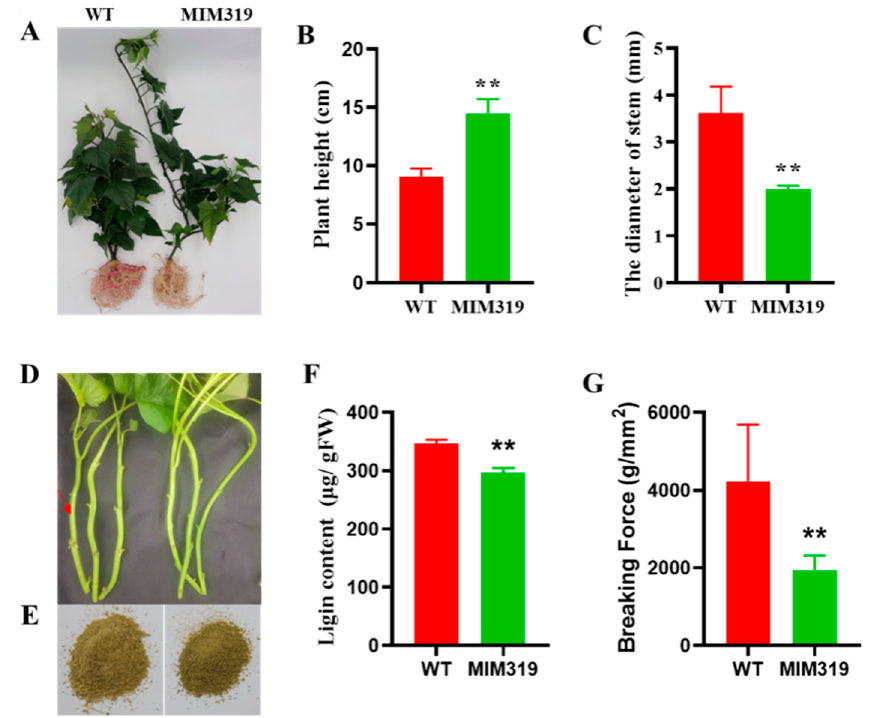
Figure 3. Phenotypes of MIM319 transgenic sweet potato plants. ( A ): The transgenic plants (MIM319) exhibited an increased plant height and decreased stem diameter compared to the WT controls. ( B ): Statistical analysis of plant height in MIM319 transgenic plants and WT ( n = 20). ( C ): Statistical analysis of stem diameter in MIM319 transgenic plants and WT ( n = 20). ( D ): A closer look at the MIM319 transgenic plants and WT. The representative transgenic plant stem is slender. The red arrow indicates the sample location. ( E ): Powdered stems of MIM319 (left) and WT (right). ( F ): Statistical analysis of lignin content in WT and MIM319 transgenic plants ( n = 10). ( G ): The breaking force of the stems in the WT and MIM319 transgenic plants ( n = 20). Data are presented as means ± SE, and error bars represent SE. ** indicate significant differences between transgenic and control plants at p < 0.01 by Student’s t -test.